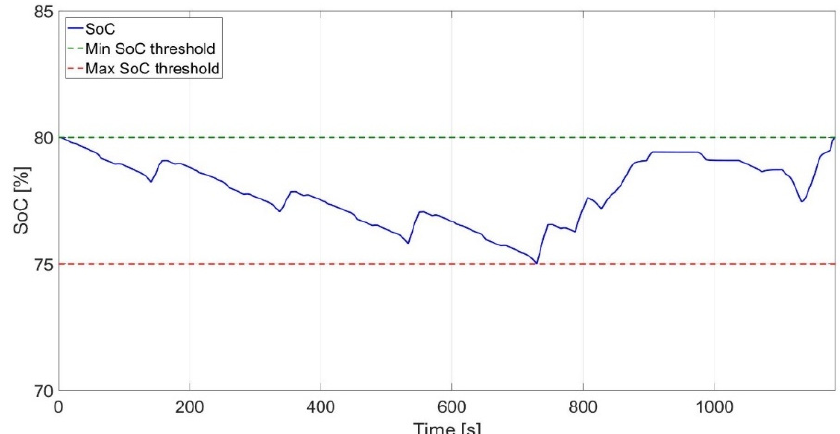
Figure 24. SoC trend, ECMS-based EMS.